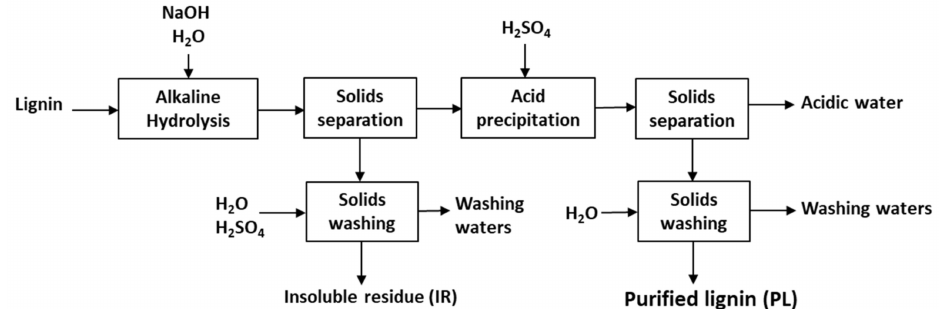
Figure 10. Schematic representation of the alkaline hydrolysis-acid precipitation lab scale protocol.